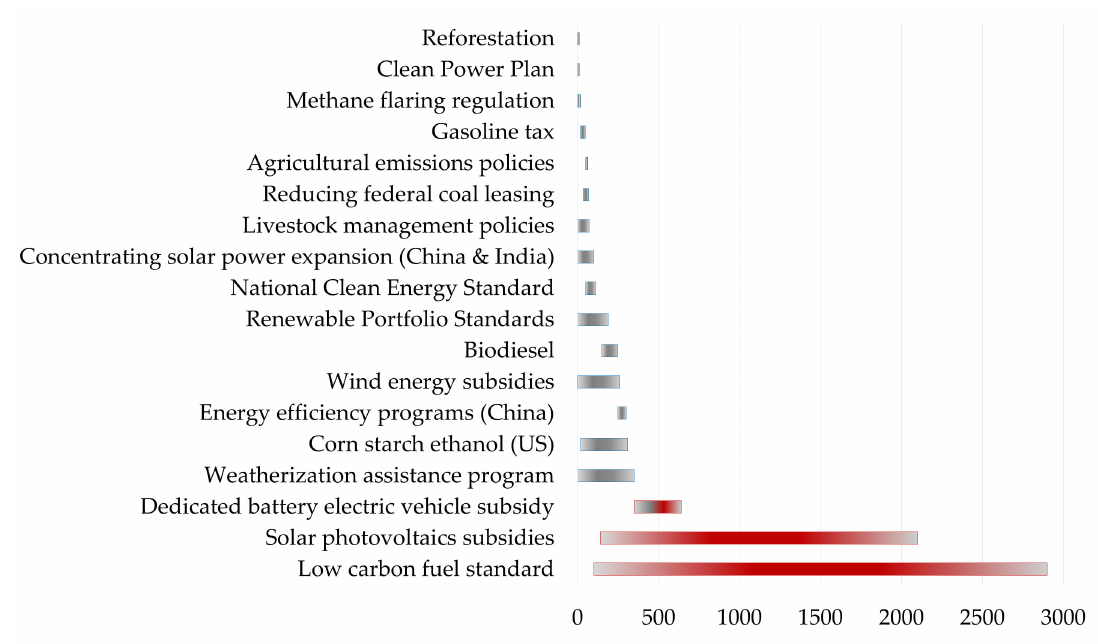
Figure 4. Static costs of policies, USD/t CO